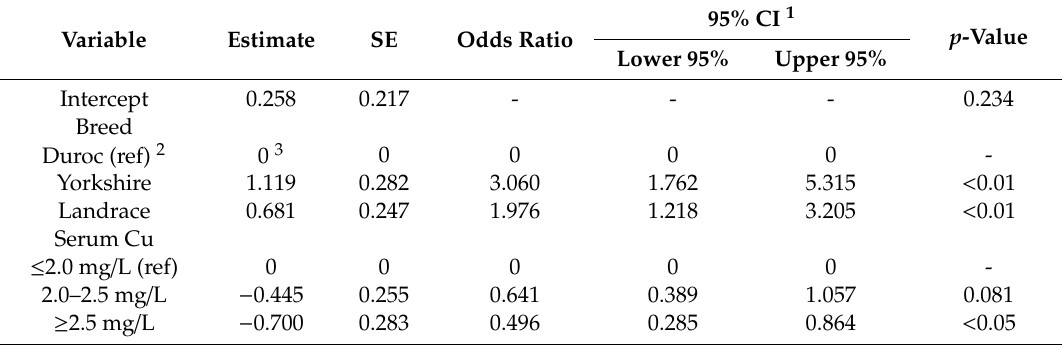
Table 5. The factors that influence the sperm motility were extracted by forward selection in binary logistic regression analysis (n = 385).